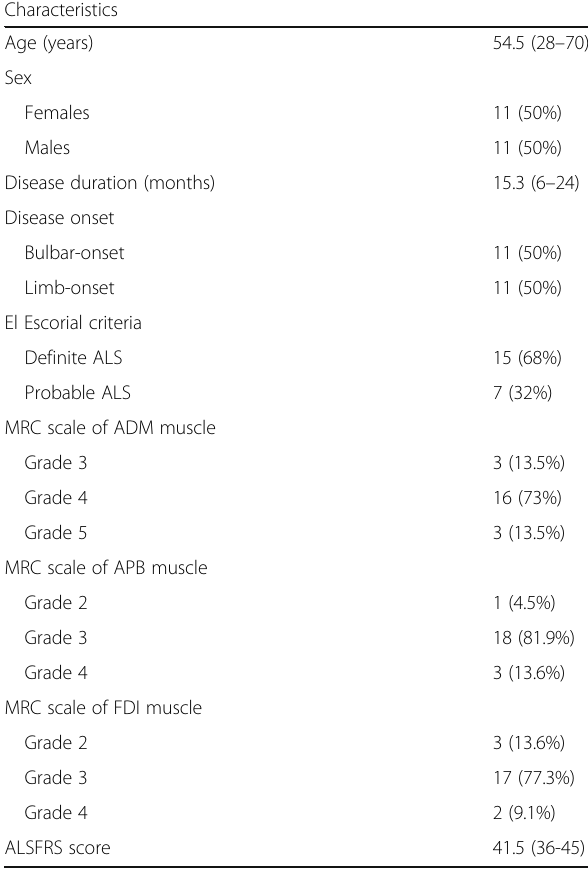
Table 1 Descriptive and clinical characteristics of patients with ALS